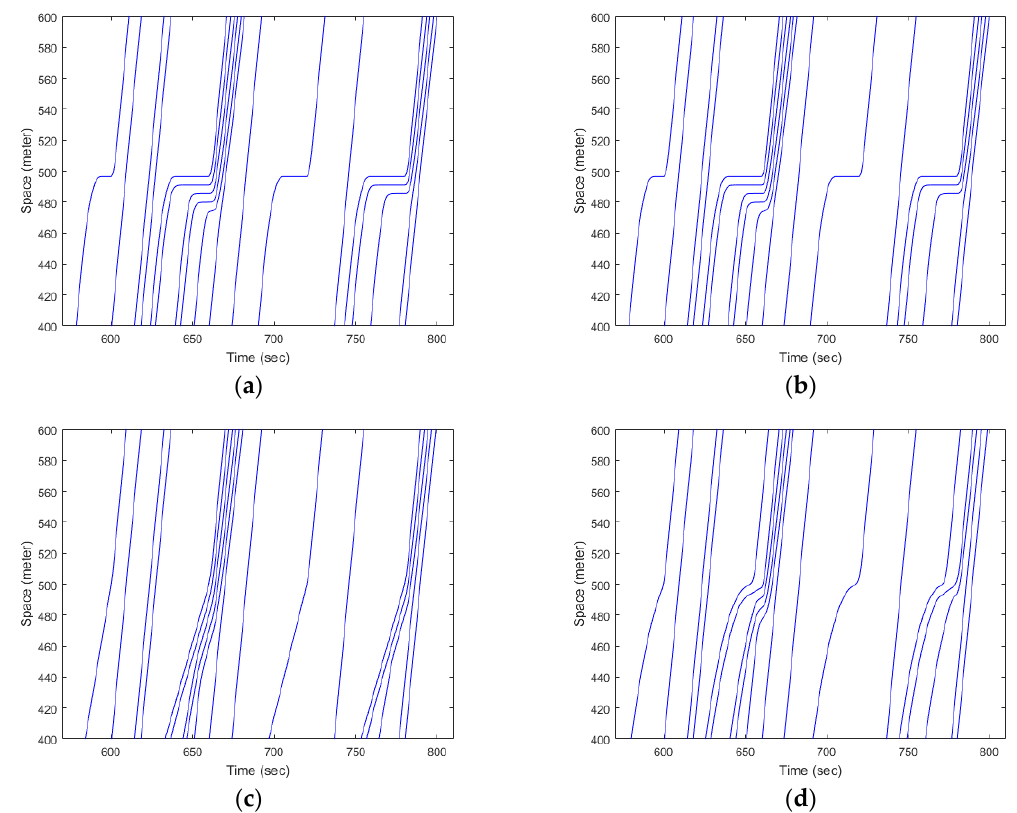
Figure 7. Comparison vehicle speed trajectories by (a) uninformed drive for ICEVs; (b) uninformed drive for BEVs; (c) ICEV Eco ‐ CACC ‐ I; (d) BEV Eco ‐ CACC ‐ I.